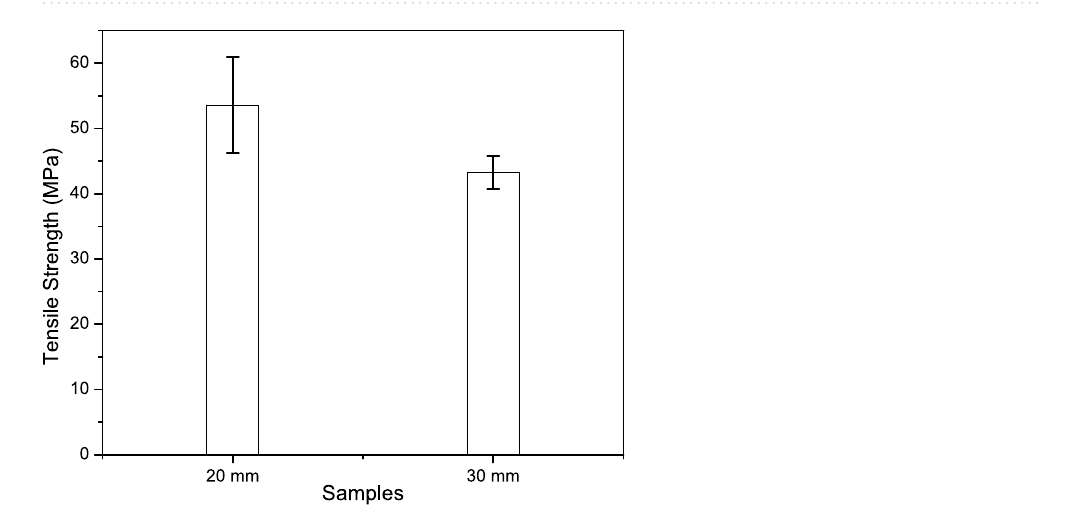
Figure 5. Images of single fiber tensile strength test ( a ) Sample preparation, ( b ) Sample setting with jaw, ( c ) Universal Testing machine.